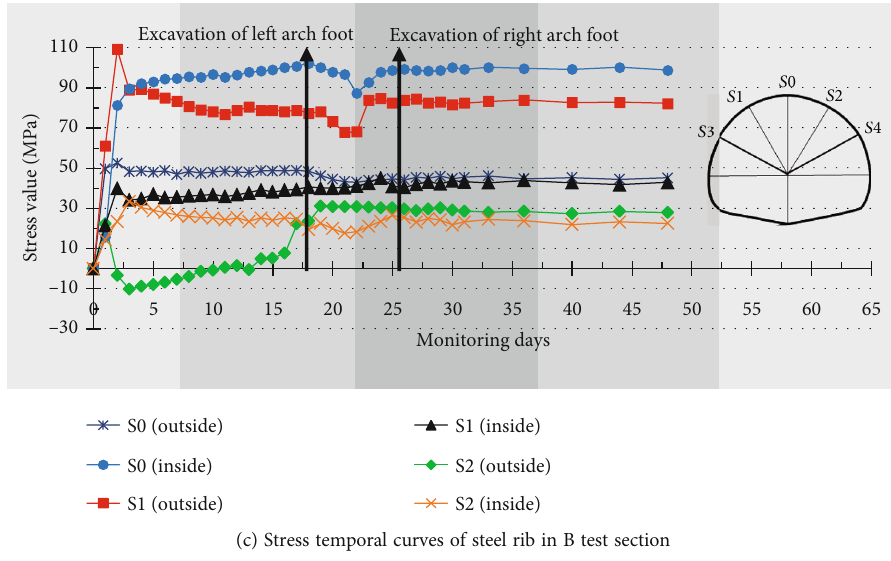
Figure 3: Stress temporal curves of steel